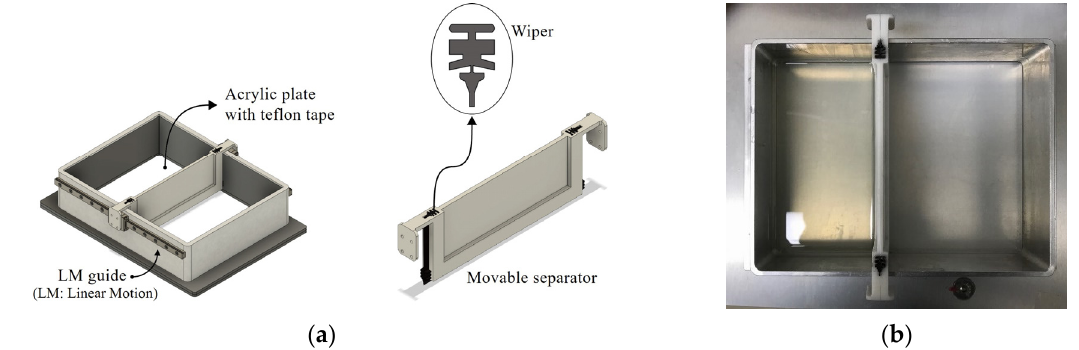
Figure 3. Vat with movable separator: ( a ) schematic diagram; ( b ) photo of the fabricated vat. Table 1. Printing conditions for test specimen fabrication.